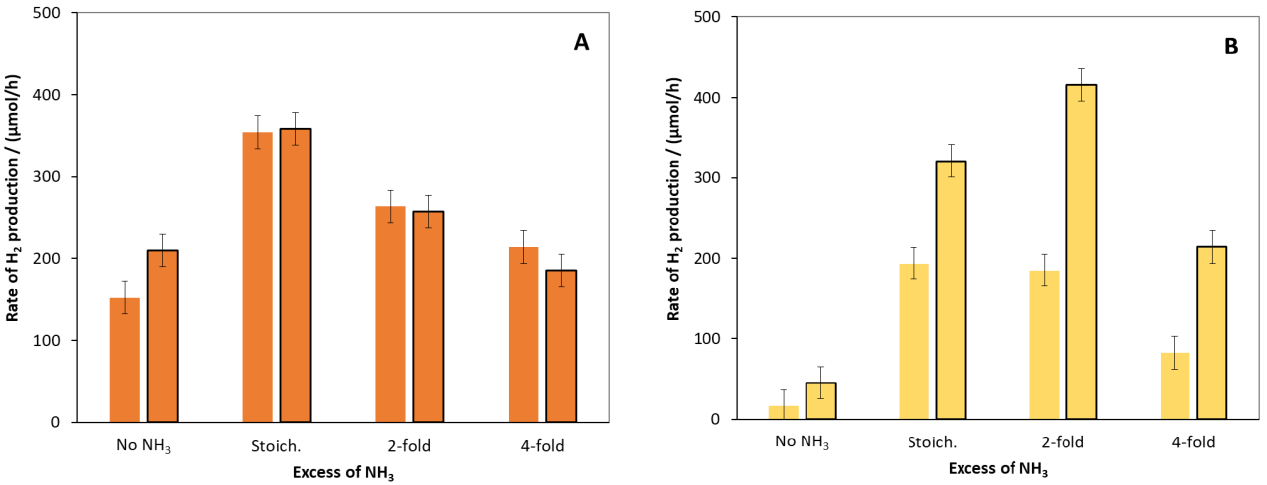
Figure 3. The rate of H 2 production for catalysts precipitated from solutions containing different amounts of ammonia. (For comparison, the rates for the catalyst prepared without NH 3 , designated as “No NH 3 ”, are also shown, along with those for that prepared in the presence of stoichiometric amount of NH 3 , designated as “Stoich.”). ( A , B ) show the hydrothermally treated and untreated catalysts, respectively. The bordered bars symbolize the surface modification of catalysts with 0.1% Ni content. The primary volume vs. time functions and their time derivates (as rate of H 2 evolution) are given in the Supplementary Materials as Figure